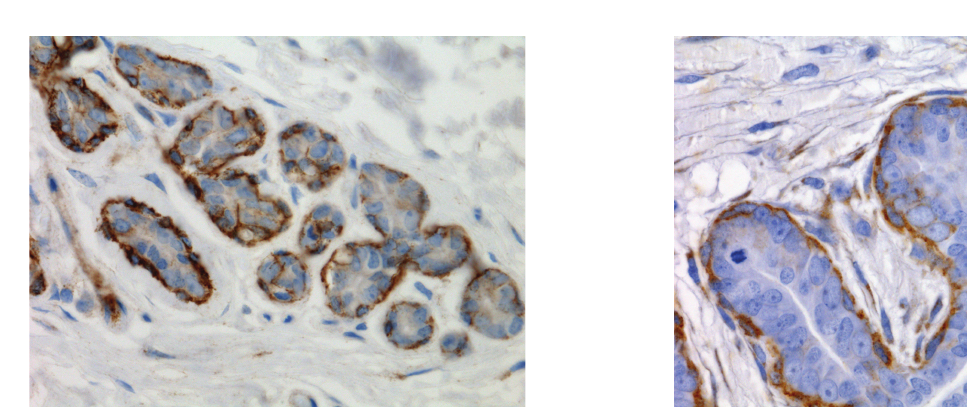
Figure 1: Normal mammary gland. Membranous and cytoplasmic P-cadherin immunoreactivity in myoepithelial cells (streptavidin- biotin-peroxidase method, 630x).